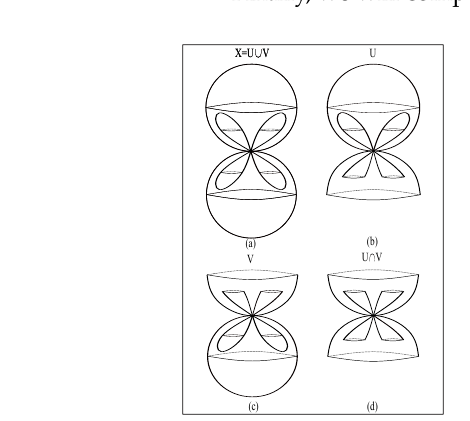
Figure A3. Open sets U and V for computing the cohomology group H 2 ( X )